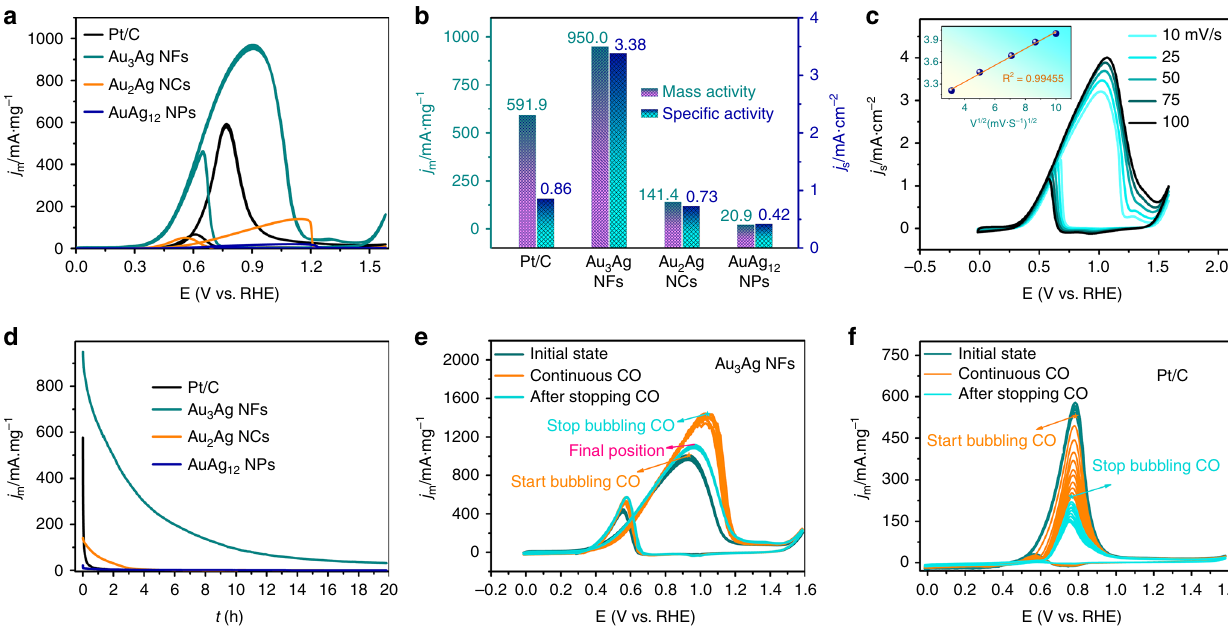
Fig. 4 Electrocatalytic performances of Au – Ag nanostructures. a Cyclic Voltammetry (CV) curves taken at a sweep rate of 20 mV s − 1 for all examined catalysts. b The corresponding histogram of mass and speci fi c activities. c CVs of Au 3 Ag NFs taken at various scan rates. The inset shows a linear response of current density with respect to the square root of scan rates. d Chronoamperometric i – t curves of all examined catalysts up to 20 h. e Evolution of CV curves for Au 3 Ag NFs with the CO supply turned on and off for a continuous 10 cycles. f Evolution of CV curves for Pt/C with the CO supply turned on and off for a continuous 10 cycles. The methanol oxidation reactions were performed in deoxygenated solutions of 2 M CH 3 OH and 0.5 M